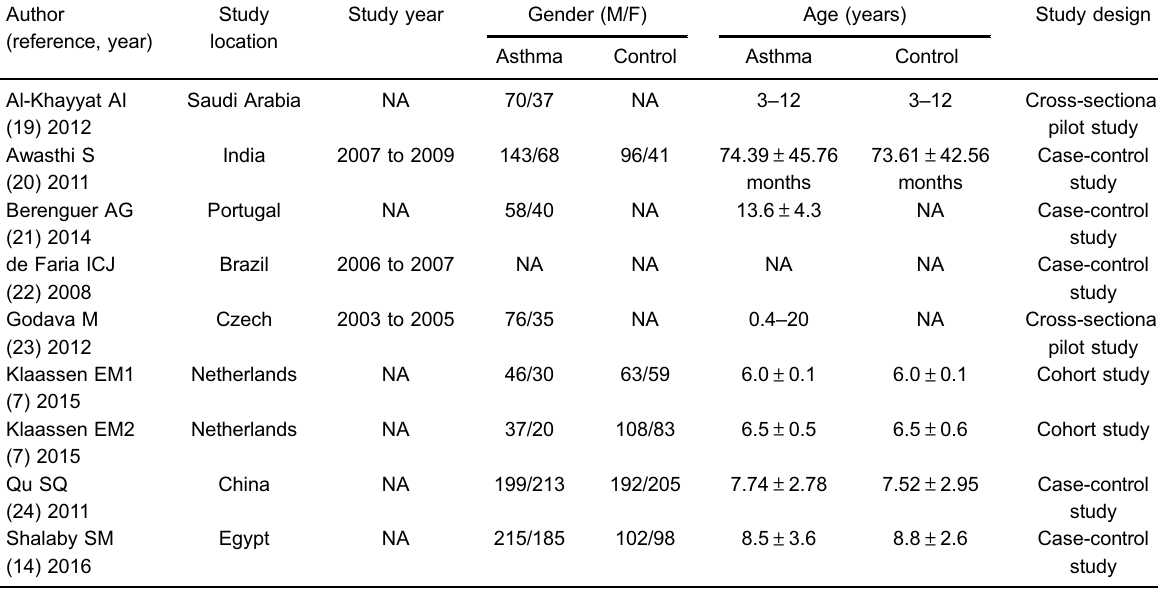
Table 1. Characteristics of the included